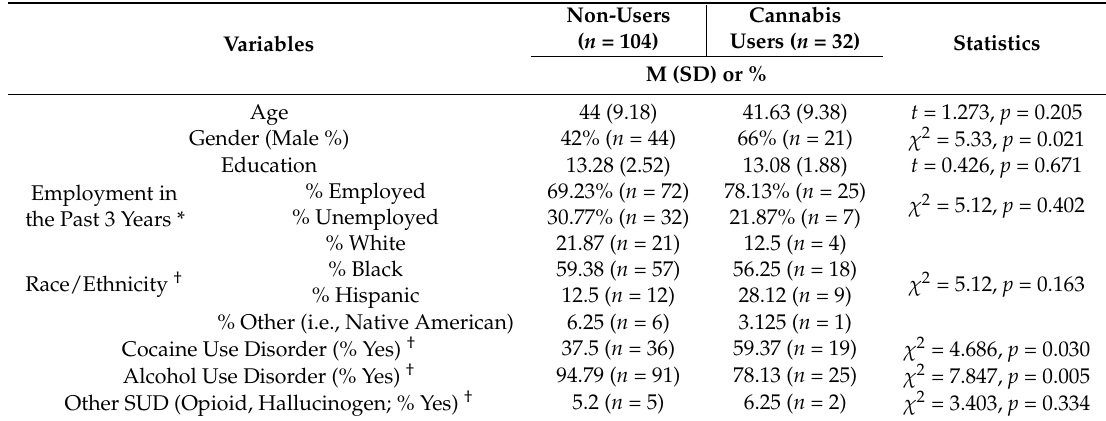
Table 1. Participants’ characteristics by cannabis use. SUD, Substance Use